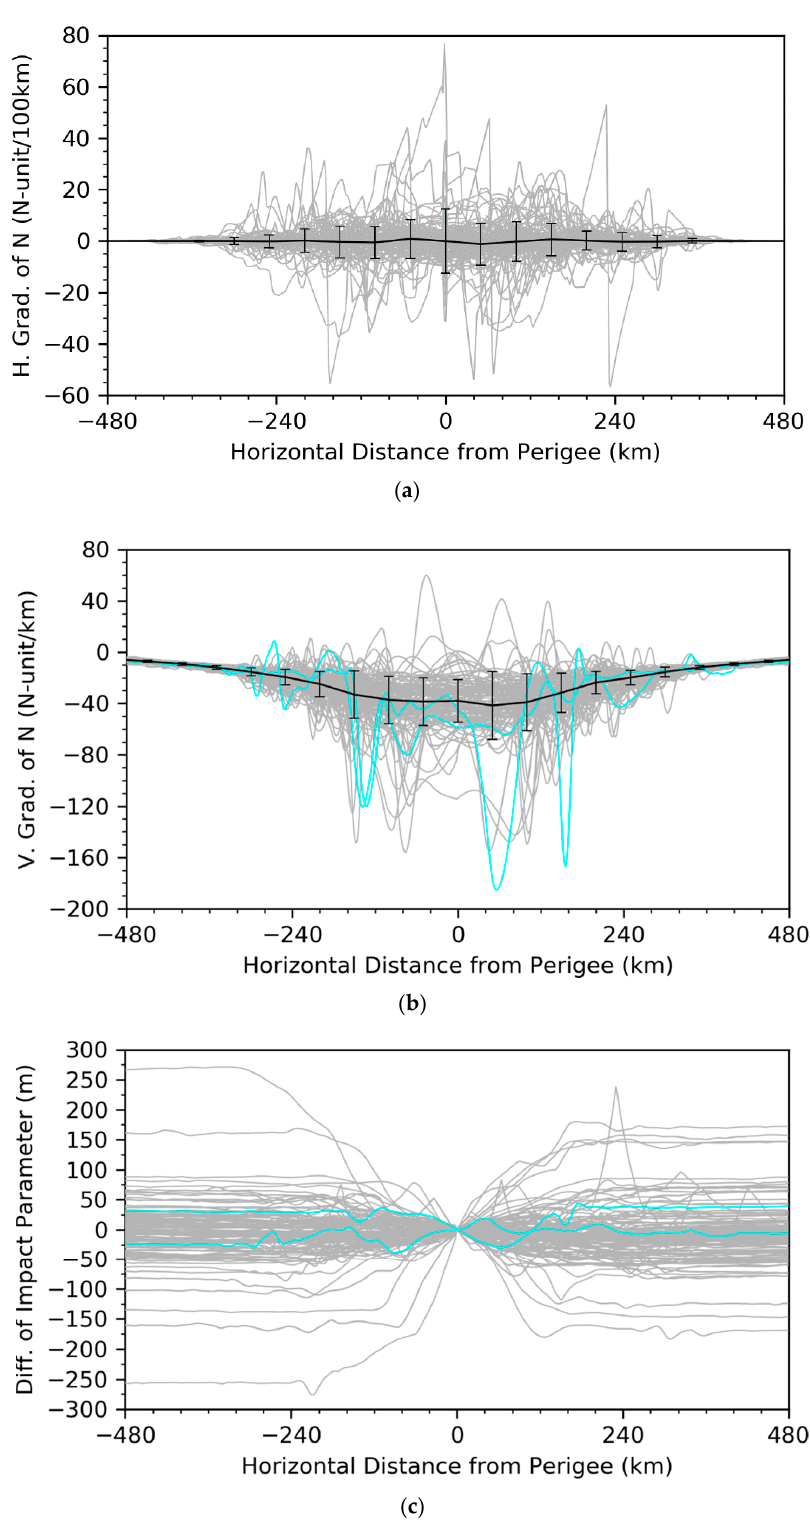
Figure 9. Along-the-ray variations in ( a ) horizontal gradients, ( b ) vertical gradient (gray and cyan curves) and ( c ) difference of impact parameter from the perigee ( a − a 0 ) for rays whose impact heights at the perigee are between 3.399 and 3.401 km for all simulations. Shown in ( a , b ) are the means ( µ black solid curve) and one standard deviations ( σ , short black vertical lines) of the vertical gradients of N wet calculated at 50-km horizontal-distance intervals. The two rays along which there are occurrences of super-refraction (vertical gradient of N is less than − 157 N-unit km − 1 ) are shown in cyan in ( b , c ). The two rays along which the vertical gradients of refractivity reach the super-refrac- tion condition are indicated in cyan. It is seen that the along-the-ray variations for these two rays are not necessarily largest since the regions of super-refraction are narrow and away from the perigee, confirming that horizontal gradients cause the largest along-the- ray variations in the impact parameter near the perigee. The mean values and standard deviations values of the differences in the impact pa- rameters for rays with different values of the largest vertical gradient of wet refractivity are shown in Figure 10. Both the mean values (Figure 10a) and standard deviations values (Figure 10b) decrease as the largest vertical gradient of wet refractivity decreases between 3.39 and 3.40 km and 6.39 and 6.40 km. The mean values and standard deviations of the differences in the impact parameters for impact heights at the perigee points between 2.69